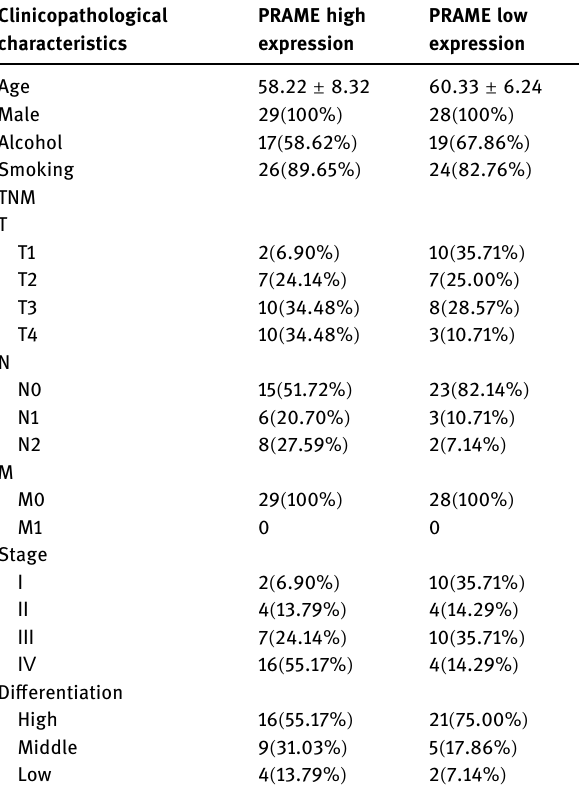
Table 2: Correlation of PRAME expression with